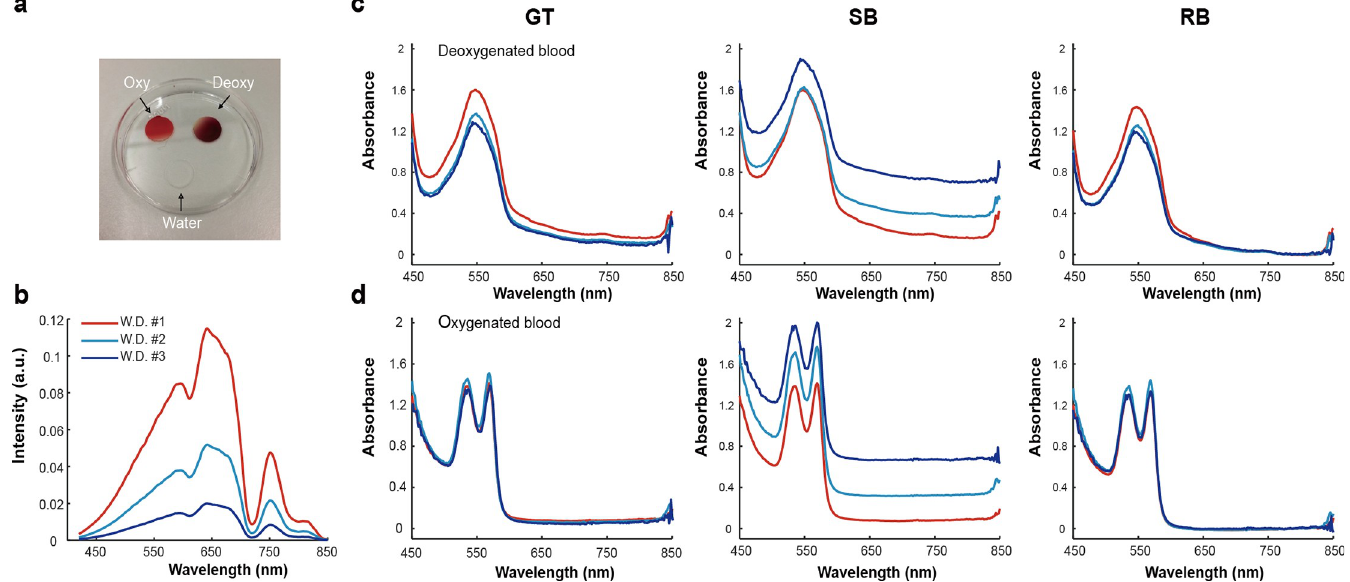
Fig 3. Retrieved background (RB) signals enable accurate measurements of absorbance of deoxygenated and oxygenated blood compared to ground truth (GT). (a) Photograph of the experiment setup. Water (control) and blood (deoxygenation and oxygenation) were covered by a cover glass to prevent the sample from drying during the measurement. Hyperspectral imaging was performed using the internal illumination method at three working distances. (b) Experimentally measured reflectance signals of a control target (water) were used GT, with different optical illumination power according to working distance. Absorbance of deoxygenated (c) and oxygenated (d) blood measured at three working distances were then calculated using GT, SB and RB methods, showing good agreement between GT and RB, but substantial deviation for SB method.